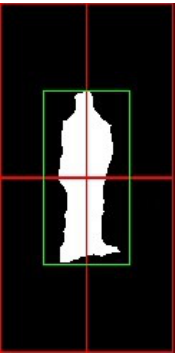
Figure 1: Regions based on a detection that are used for training, relative to a detection (white region indicates foreground region belonging to the detected object) in the image